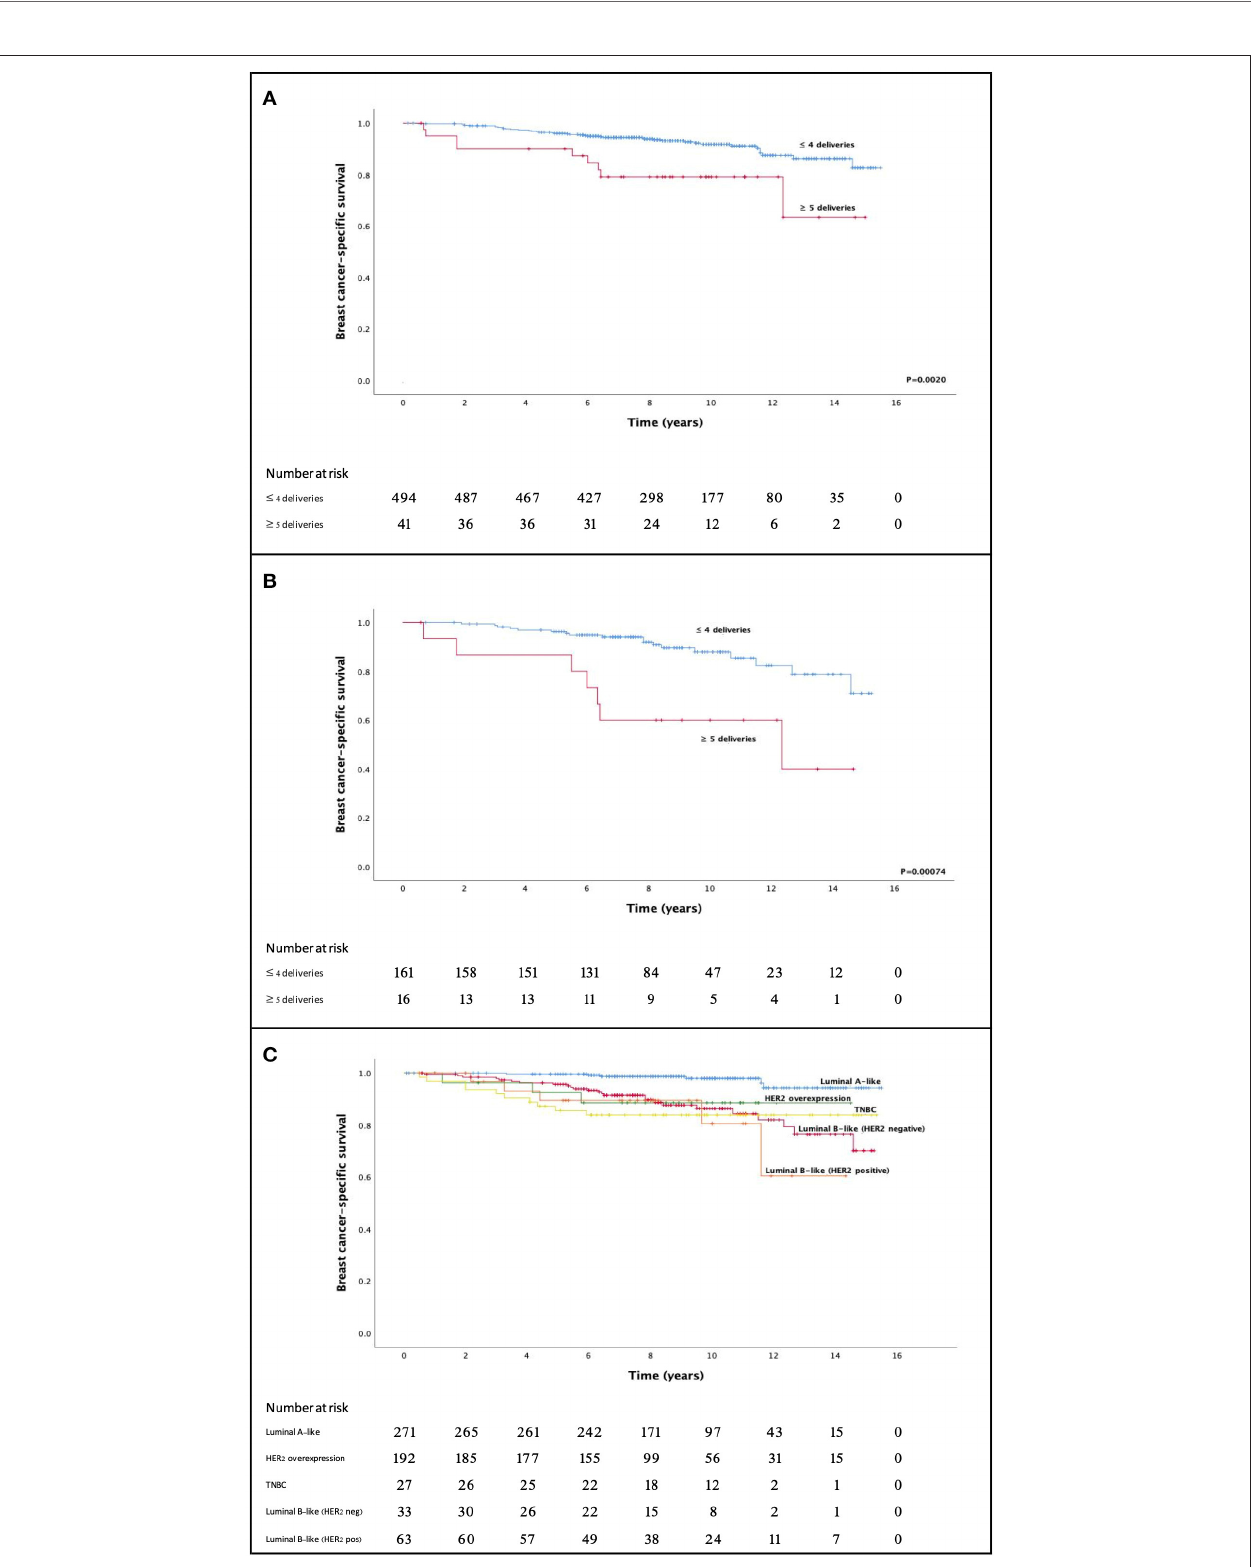
FIGURE 1 | High parity ( ≥ 5 deliveries) before breast cancer diagnosis predicted poor breast cancer-specific survival in the overall cohort (A) and separately in luminal B-like (HER2 negative) breast cancers (B) . (C) Shows the long-term breast cancer-specific survival according to the intrinsic subtype immunohistochemical surrogates. TNBC, triple-negative breast